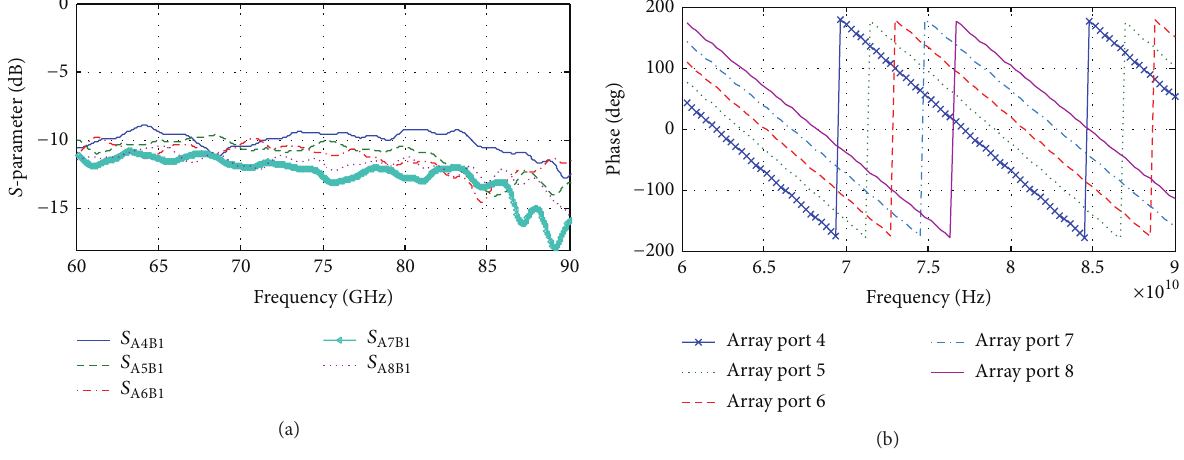
Figure 7: 𝑆 -parameter for beam port number one active, (a) magnitude, (b) phase.